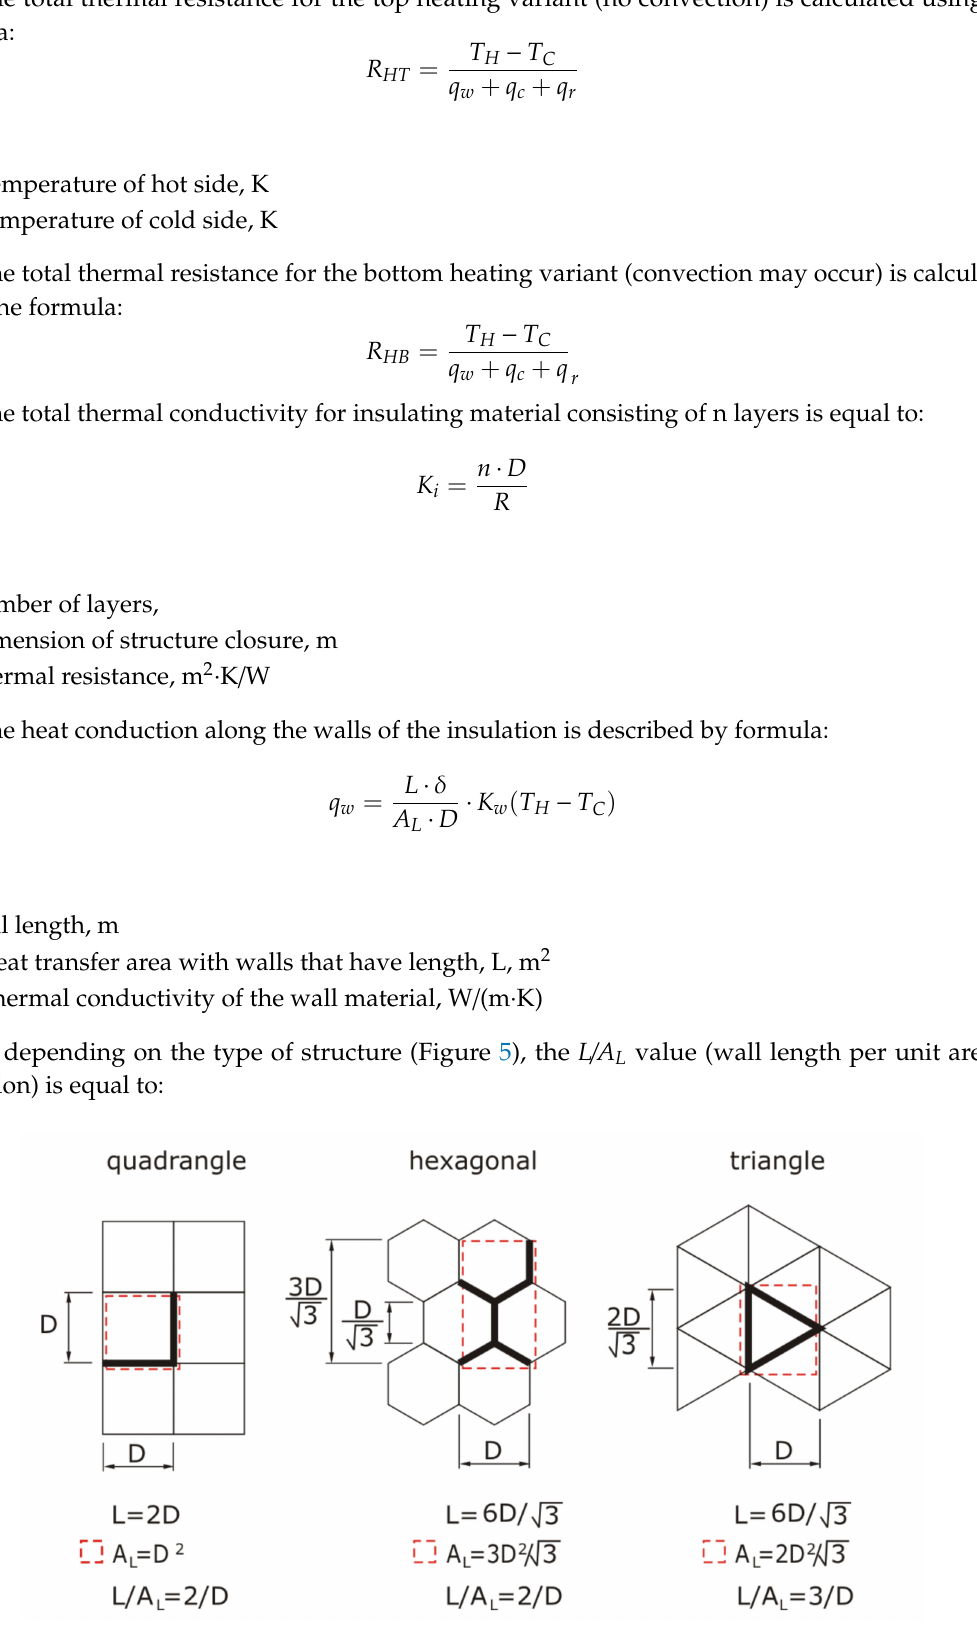
Figure 5. The dependence between the length of the walls and the type of structure in relation to its base area. The red dashed line means the heat transfer area, with walls that have length,